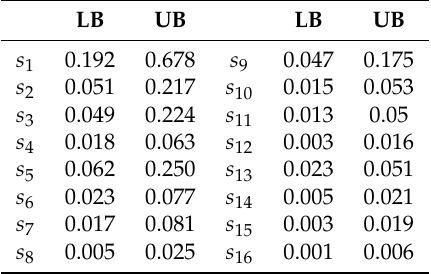
Table 1. Lower and upper bounds of state probabilities at time step t =